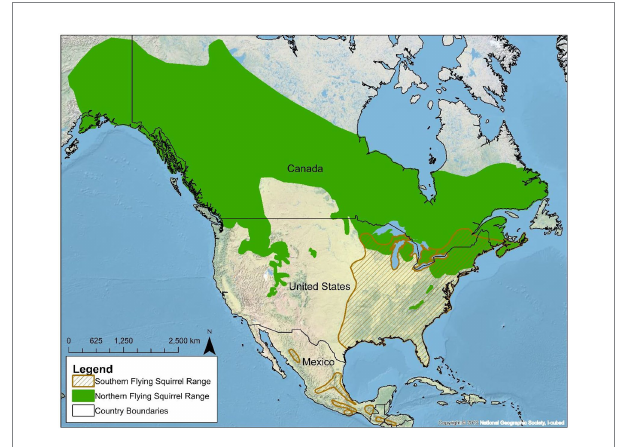
FIGURE 1 The geographic range of northern flying squirrels ( Glaucomys sabrinus ) and southern flying squirrels ( Glaucomys volans ) in North